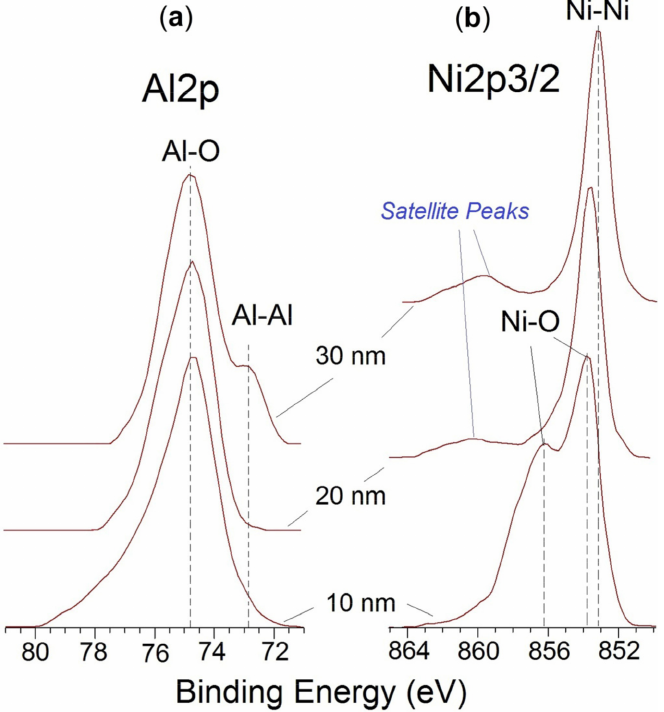
Figure 4. Al2p ( a ) and Ni2p3/2 ( b ) XPS spectra on various depths (indicated near curves) of the Al + ions irradiated